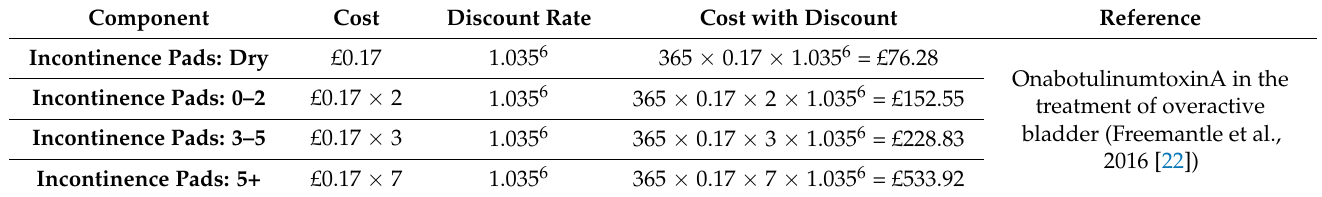
Table A4. Cost For incontinence pads.